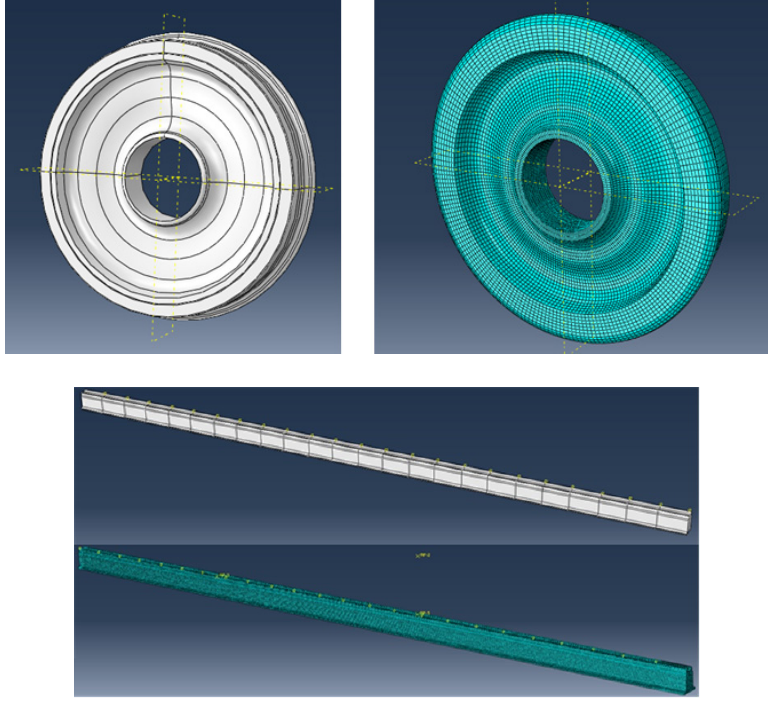
Figure 10. A finite element model of bogie wheel and stabilization railroad.